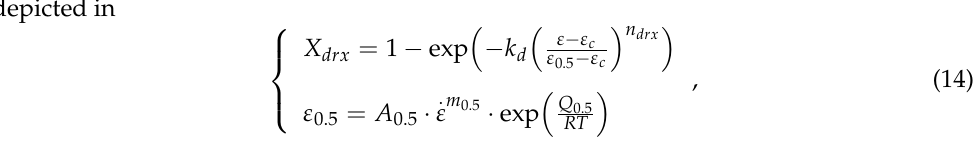
 represents 0.5  represents the c